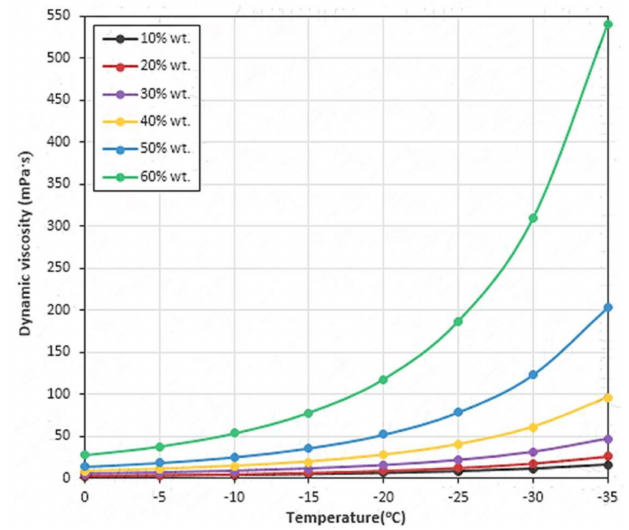
Figure 4. Dynamic viscosity of aqueous glycerol solution profiles versus temperature values depend- ing on the mass concentration of glycerol, based on literature data